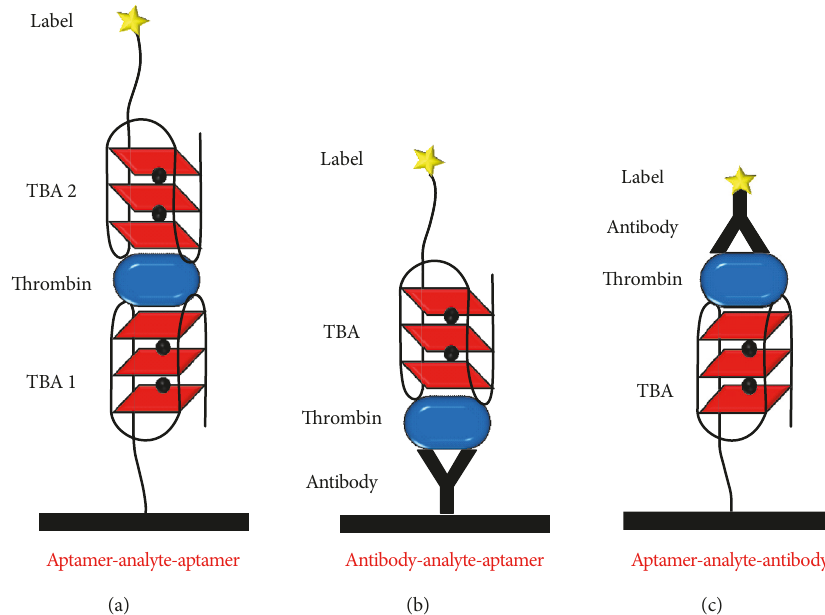
Scheme 6: Sandwich-type GQ electrochemical biosensors for the detection of thrombin: (a) aptamer-analyte-aptamer, (b) antibody-analyte- aptamer, and (c)